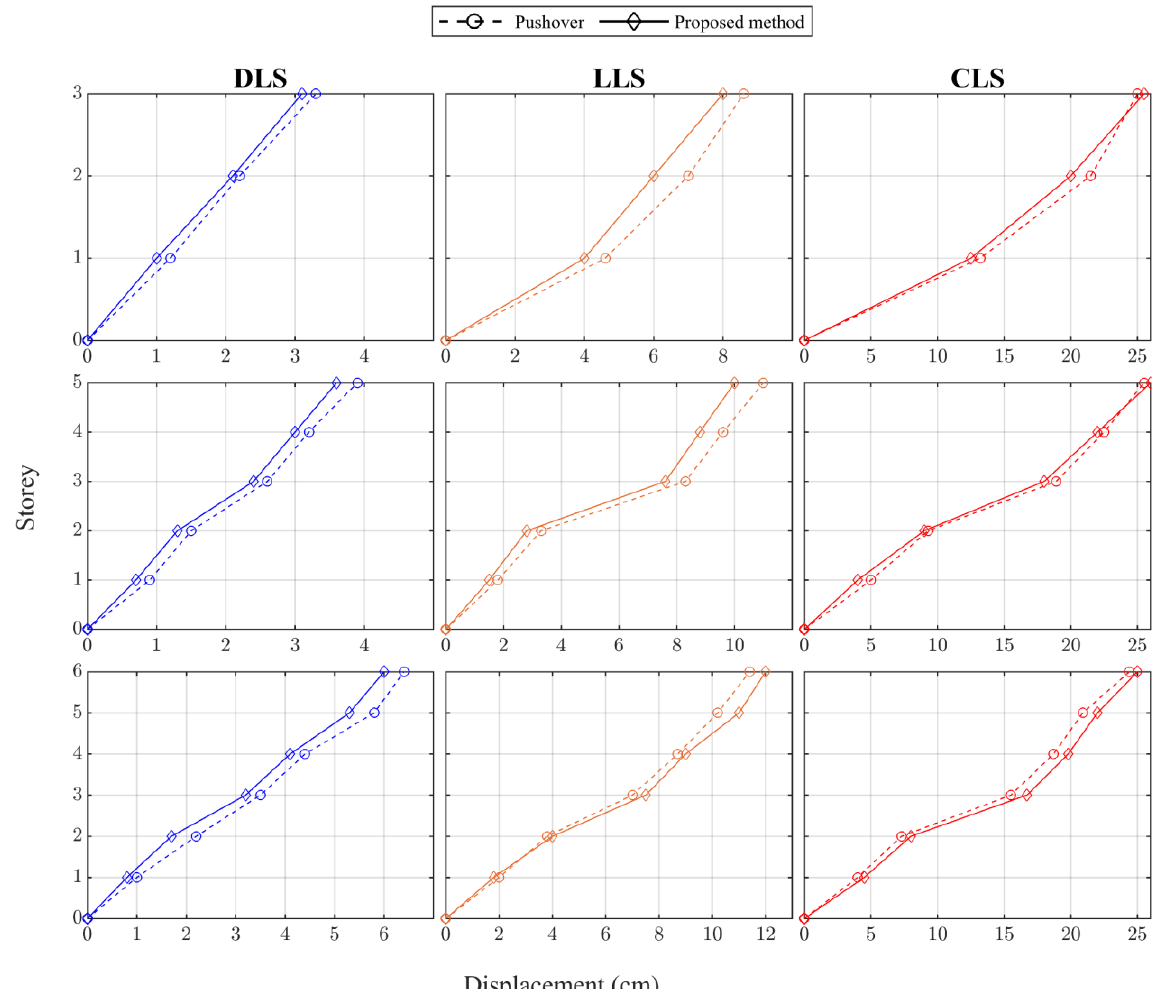
Figure 6. Comparison of the displacement profiles from the full pushover analysis (dashed lines) and the proposed analytical method (thick lines). From above: Case 1 (3 storeys), Case 2 (5 storeys), and Case 3 (6 storeys).